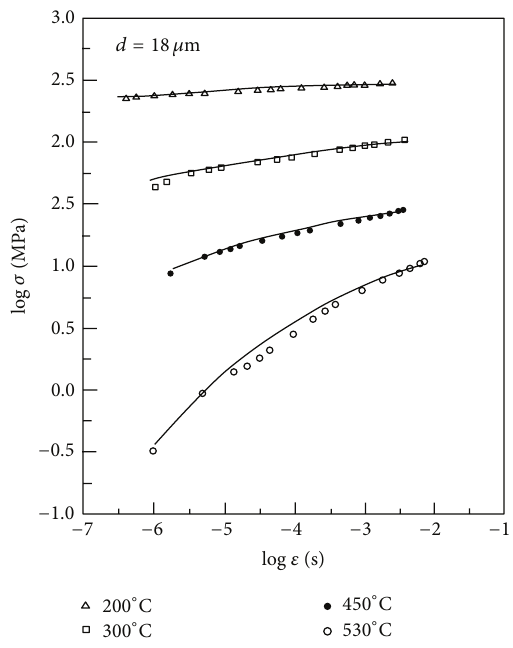
Figure 5: The effect of temperature on the flow behavior of 8090 Al-Li with the average grain size of 18 𝜇 m. Table3:Theconstitutiveparametersfor ̇𝛼 elementdeterminedfrom the load relaxation test results of 8090 Al–Li with the grain size of